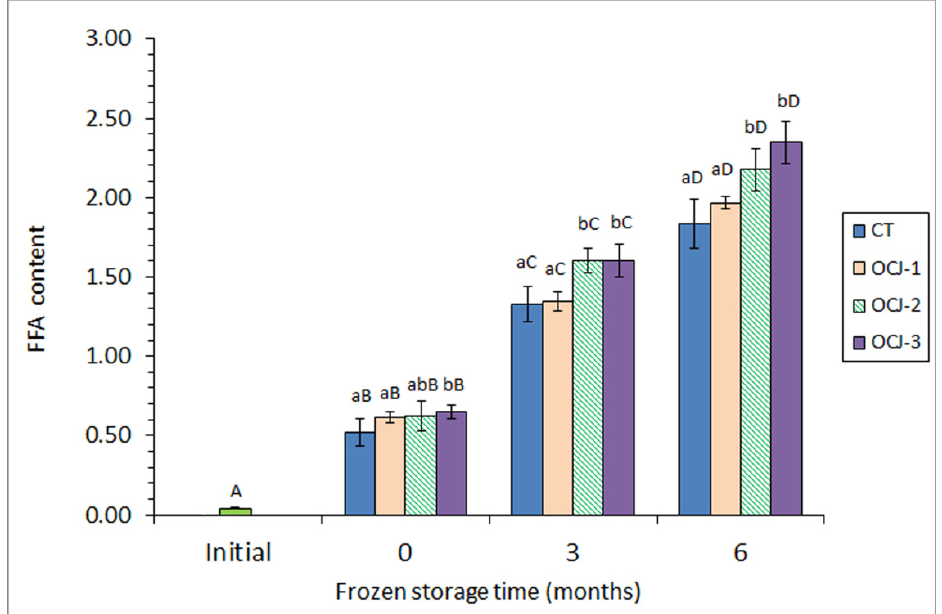
Figure 2. Determination of free fatty acid (FFA) content (g·kg − 1 muscle) in initial and canned horse mackerel previously subjected to frozen storage and canned with different packing systems. Average values of four ( n = 4) replicates; standard deviations are indicated by bars. Different capital letters (A–D) indicate significant differences ( p < 0.05) as a result of previous frozen storage time. Different lowercase letters (a, b) indicate significant differences ( p < 0.05) as a result of OCJ presence. Packing systems as expressed in Table 1.